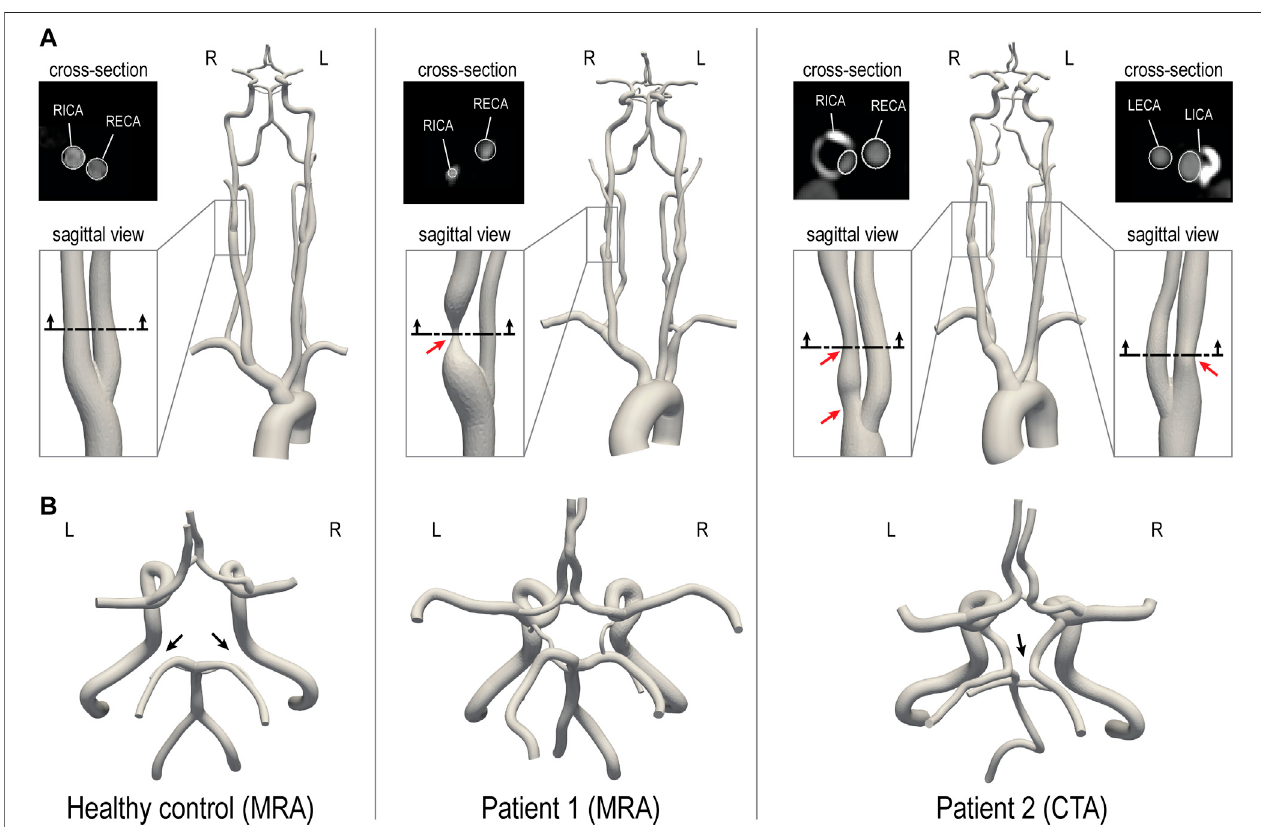
FIGURE 1 | 3D-reconstructed geometric models of a healthy control and two CVOD patients. (A) For each patient, a close-up of the stenosis is shown. The red arrows indicate the location of the stenosis. An axial cross-section of the stenosis illustrates a comparison between image data and model contours (this comparison is also shown for the healthy volunteer). (B) Posterior view ofthe CoW. The black arrows indicate variations in the CoW anatomy.RICA, right internal carotid artery; RECA, right external carotidartery;LICA,leftinternalcarotidartery;LECA,leftexternalcarotidartery.Rand Lindicate therightandleft sidefrom thesubject ’